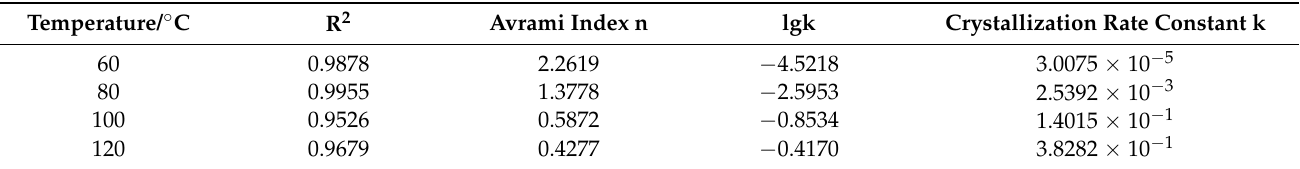
Table 6. Kinetic parameters at different temperatures.